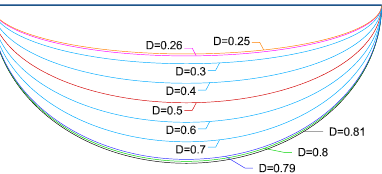
Figure 3. Semi-elliptical cavity geometries with different aspect ratios.